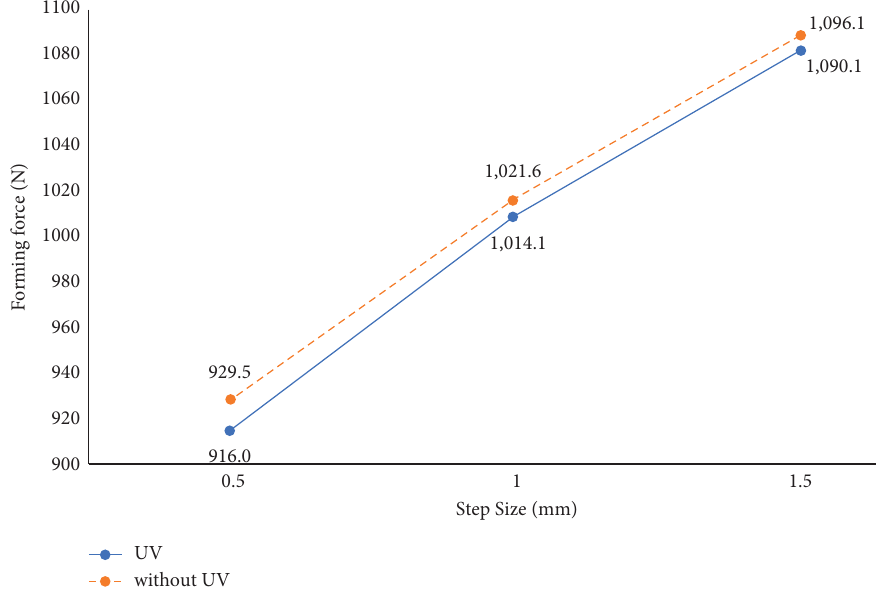
Figure 13: Forming force with diferent step sizes. Table 5: Simulation setup and results with diferent step sizes.